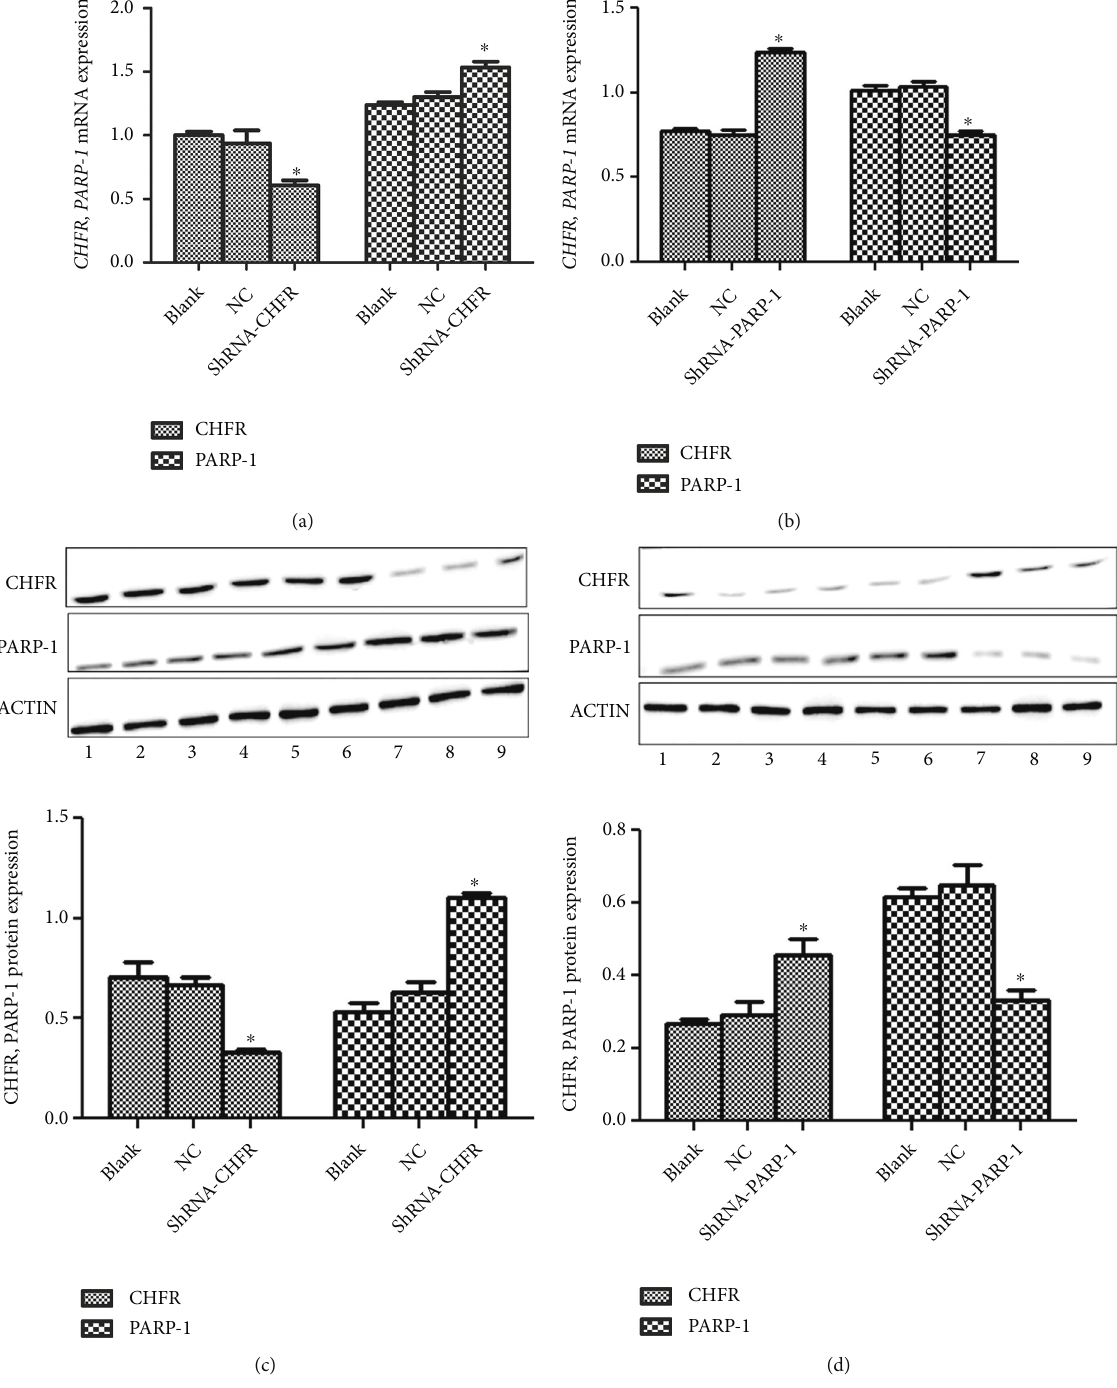
Figure 3: The cell transfection e ffi ciency after the cells ’ transfection with negative control (NC), sh-CHFR, and sh-PARP-1 lentivirus for 48 hours was evaluated by determining the expression of CHFR and PARP-1. The mRNA expression levels of CHFR and PARP-1 after CHFR interference (a) and PARP-1 interference (b) determined by RT-qPCR. The protein expression levels of CHFR and PARP-1 after CHFR interference (c) and PARP-1 interference (d) measured by western blotting. 1 – 3: the cells without treatment (blank group); 4 – 6: the cells transfected with NC (NC group); 7 – 9: the cells transfected with sh-CHFR or sh-PARP-1 lentivirus (transfection group). * P < 0 : 05 , compared with the blank